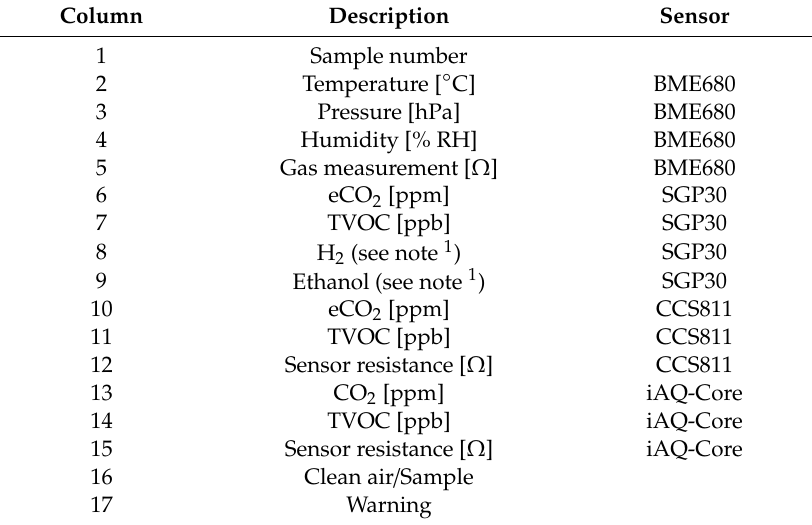
Table 2. Column information for each data